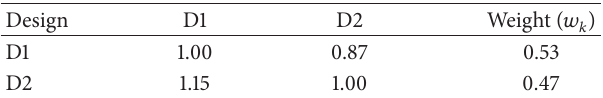
Table 8: The results of pair-wise comparison for subprecursors of Design.